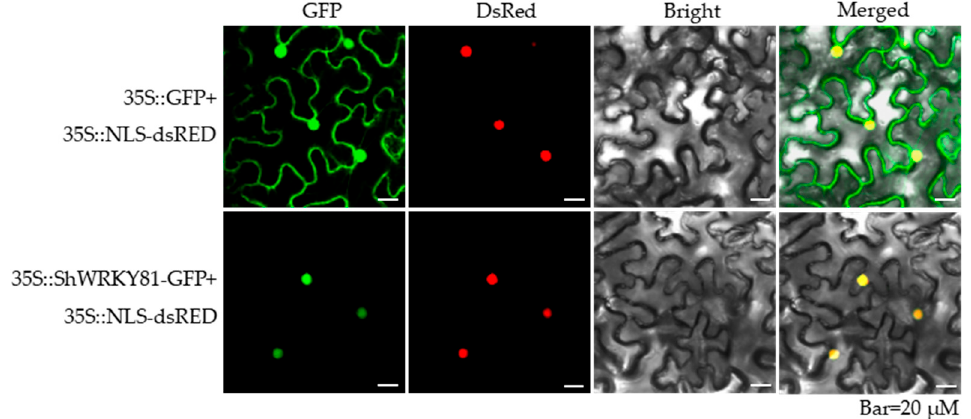
Figure 3. Nuclear localization of ShWRKY81. The constructed plasmid (35S::ShWRKY81-GFP) and control (35S::GFP) in combination with 35S::NLS-dsRED (nuclear marker) were transiently overexpressed in the leaf cells of N. benthamiana via Agrobacterium -mediated transformation. Green and red fluorescence were detected and captured by a laser confocal scanning microscope at 48 h post agroinfiltration. The panels from left to right show GFP images (GFP), dsRED images (DsRed), bright images (Bright), and merged images (Merged), respectively. Bar = 20 µ m.